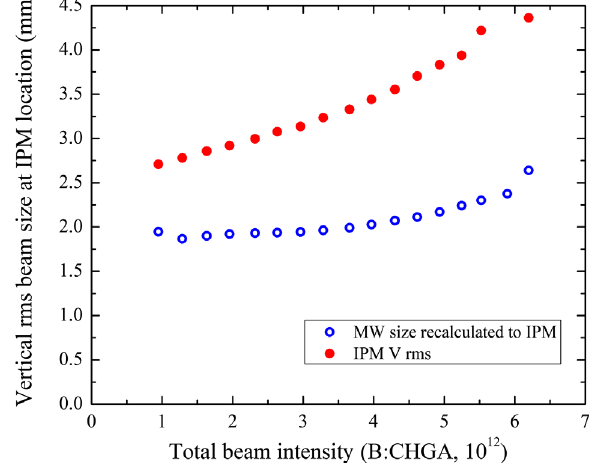
FIG. 9. Comparison of the measured rms IPM vertical beam sizes at extraction for different beam intensities with the rms sizes measured by the MWs and recalculated to the IPM